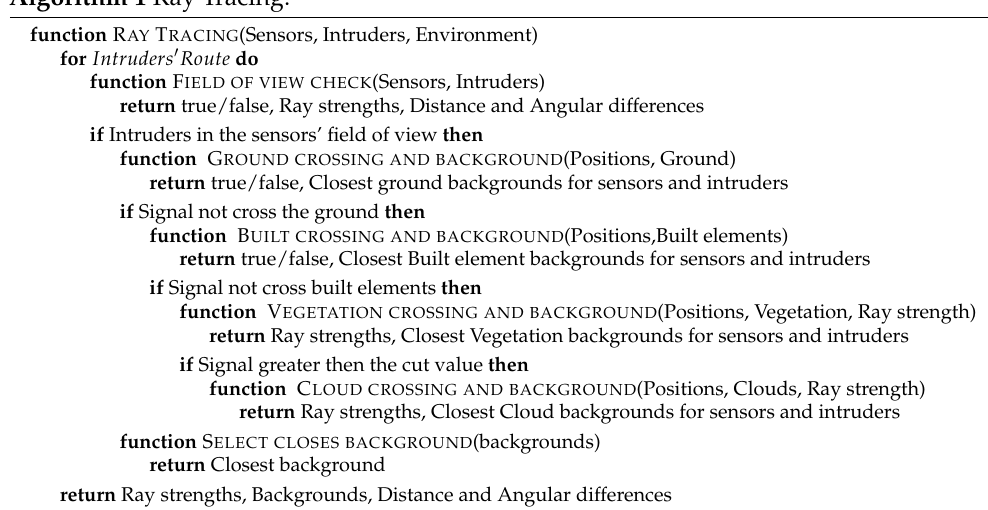
Algorithm 1 Ray